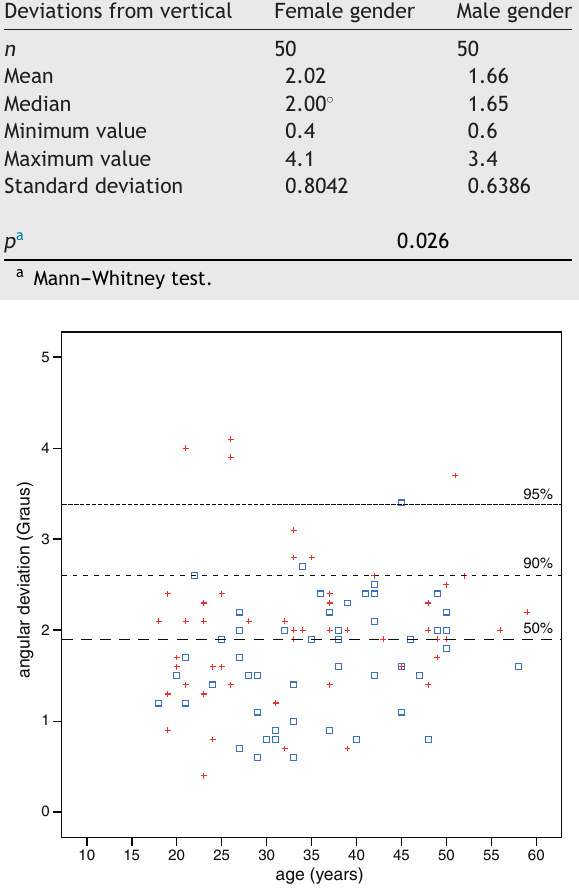
Two-dimensional scatter plot and the 50%, 90%, and 95% percentiles of the mean of the absolute values of deviations from the vertical (degrees) and the age (years) according to gender (+